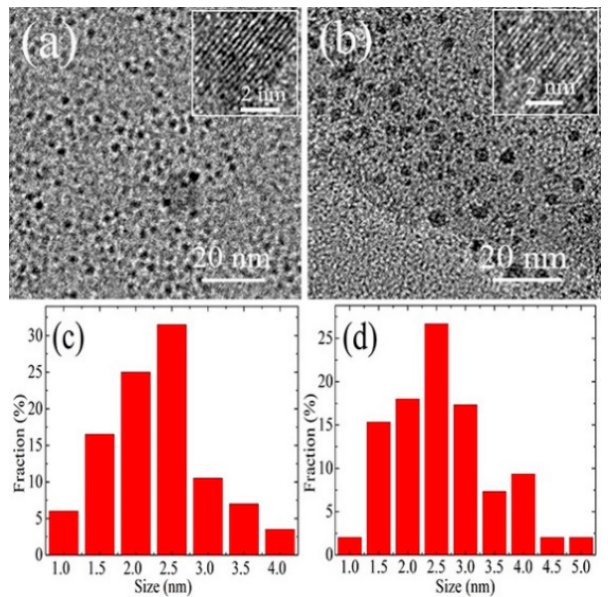
Figure 1. Transmission electron microscopy (TEM) images of ( a ) graphene quantum dots (GQDs) and ( b ) NGQDs-70 (numeric number denotes the irradiation time). Diameter distributions of ( c ) GQDs and ( d ) NGQDs-70.